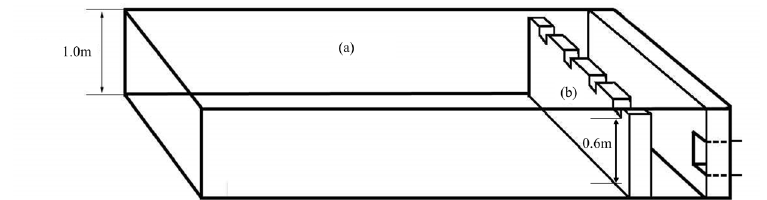
Figure 2. Concrete pit of the pig barn. (a) Slurry pit; (b)